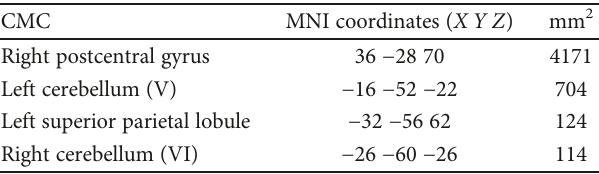
Figure 2: (a, b , and b ) Di ff usion tensor imaging. Fractional anisotropy (FA) maps were created for individuals, followed by whole-brain 1 2 tractography. This is an example of a single subject with a left hemispheric lesion. (a) Regions of interest (ROIs) for the nonlesioned (NL) and lesioned (L) corticospinal tracts (CST) were manually drawn on the native DW image, followed by tractography. The fi rst cross-sectional ROI for the CST was delineated bilaterally (NL-CST and L-CST) in the axial plane [52]. First, a “ SEED ” ROI was constructed around the PLIC at the level of the anterior commissure [53]. Second, a logical “ AND ” ROI was constructed around the CST at the level of the mid-pons [54]. The “ AND ” function constrained the reconstruction to fi bers passing through both the “ SEED ” and “ AND ” ROI. (b ) The functional motor network mask (gray ROIs) was extracted and overlaid on the DW MNI image, followed by 1 tractography of the CMC (posterior and anterior views). (b ) The motor network mask (represented in red) was overlaid on the 2 di ff usion-weighted image to create the constrained motor connectome (CMC). Table 2: Constrained motor